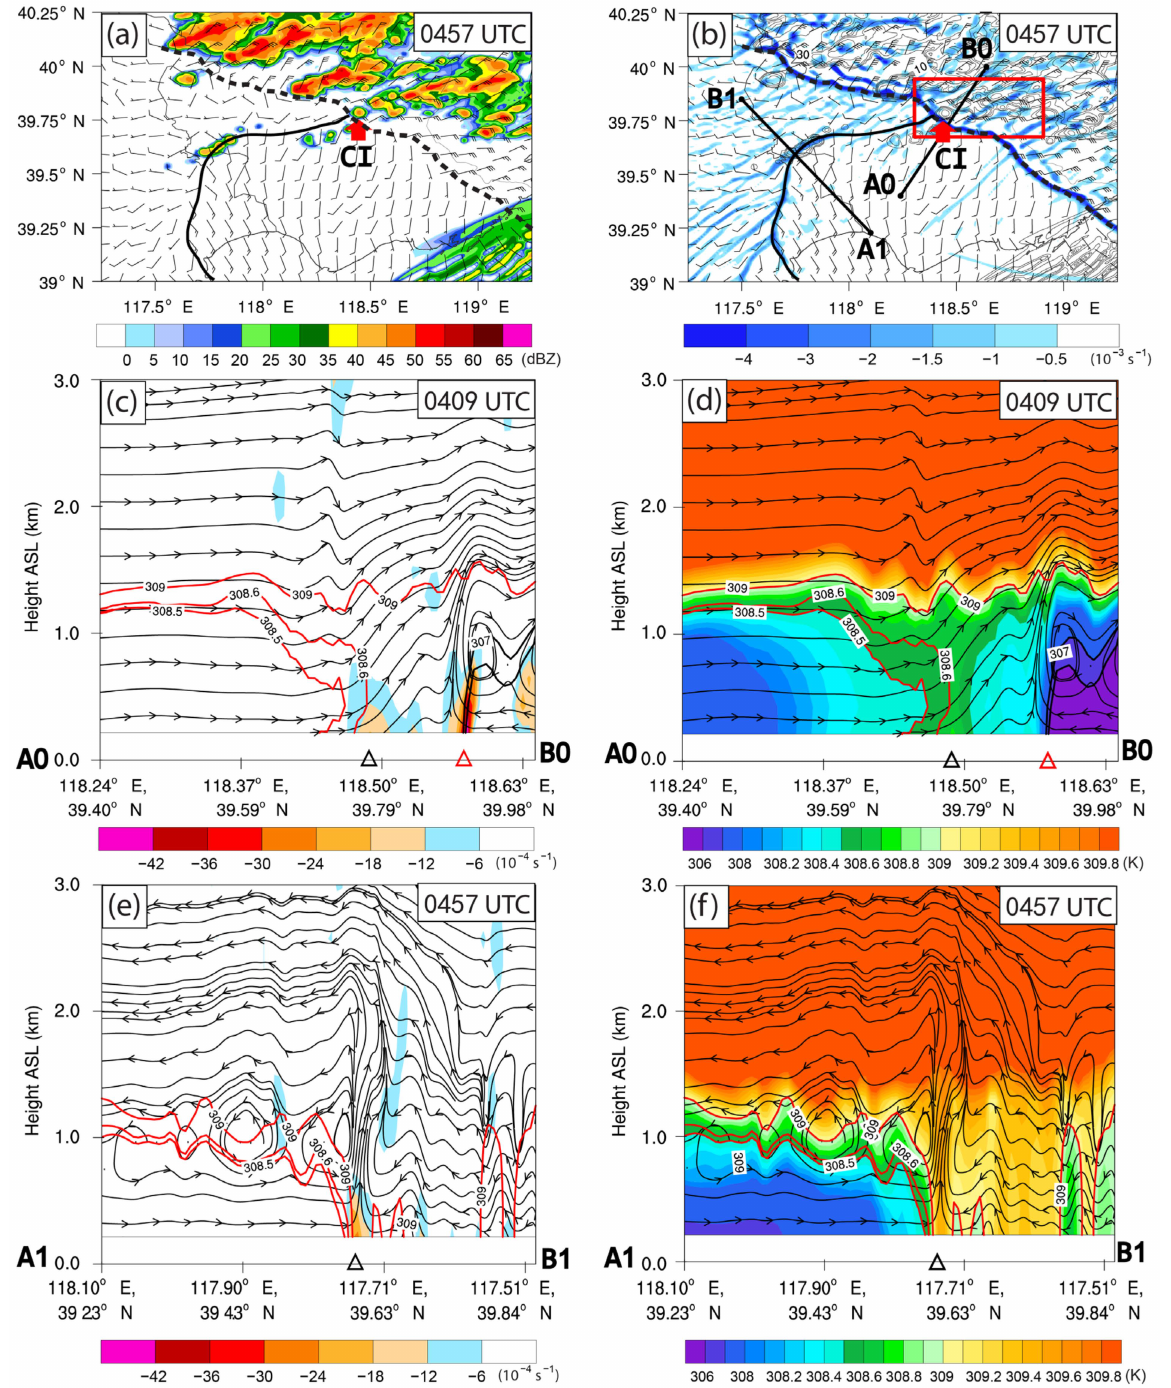
Figure 9. ( a ) Simulated composite reflectivity (shading, units: dBZ) and wind field (full and half barbs represent 4 and 2 m s − 1 , respectively) at 10 m (AGL) at 0457 UTC on 31 July 2010. The black solid and dashed lines indicate the locations of the SBF and GF, respectively. The red arrow indicates the selected convective cell; ( b ) is the same as ( a ) but for the horizontal divergence (shading, units: 10 − 3 s − 1 ) at the bottom level of simulation and composite reflectivity (black contours, units: dBZ), the line segments A0B0 and A1B1 show the locations of the vertical cross sections which will be shown in ( c – f ). The red rectangle area shows the area for calculating the zonal-mean value of horizontal divergence, horizontal wind velocity, and vertical wind shear which will be shown in Figure 15; ( c ) The vertical cross section of horizontal divergence (shading, units: 10 − 4 s − 1 ), wind stream